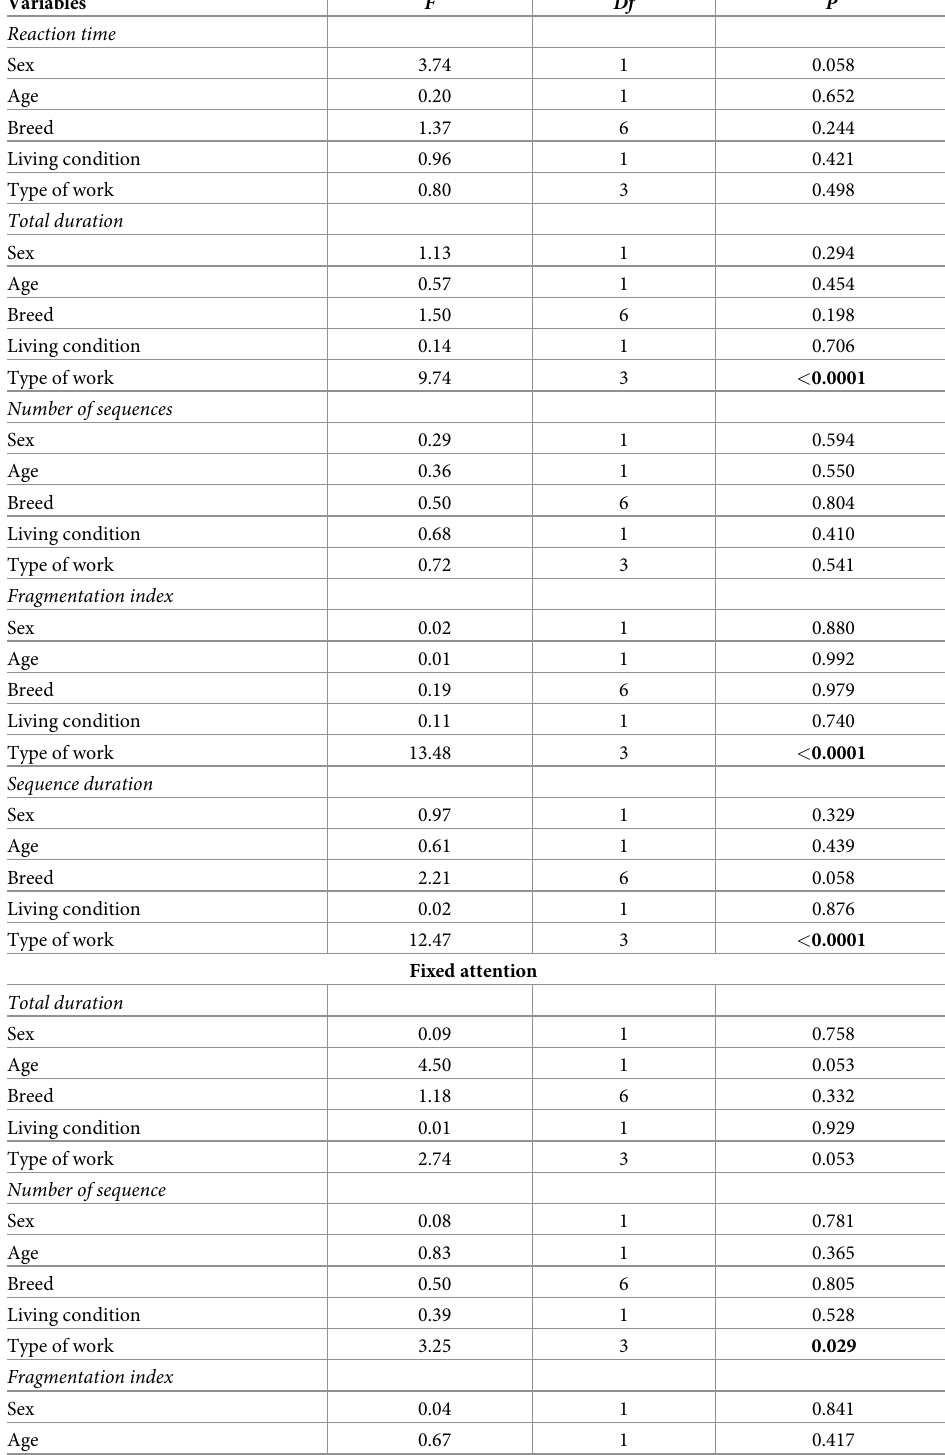
Table 1. Attention characteristics and influence of intrinsic (sex, age, breed) and of living condition and type of work.